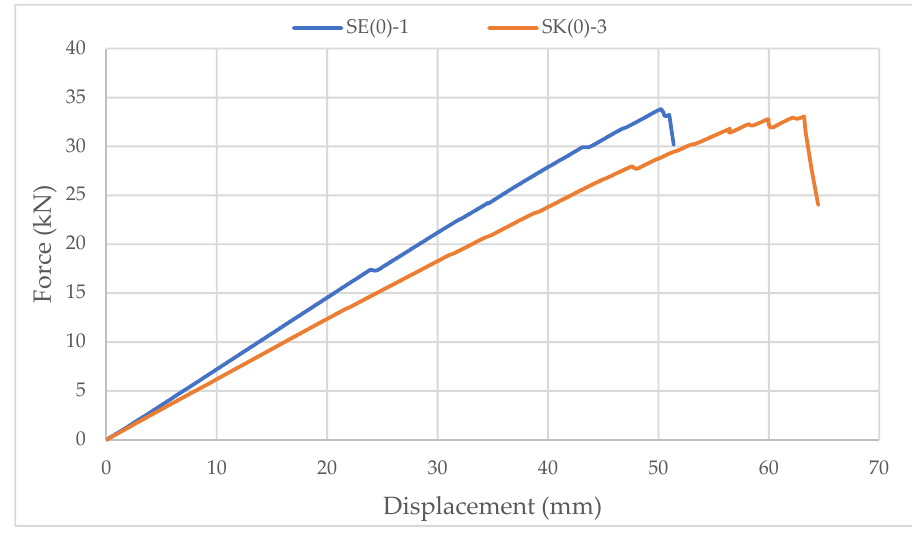
Figure 14. Force-displacement curve for strong-axis bending of samples with circular cavities.